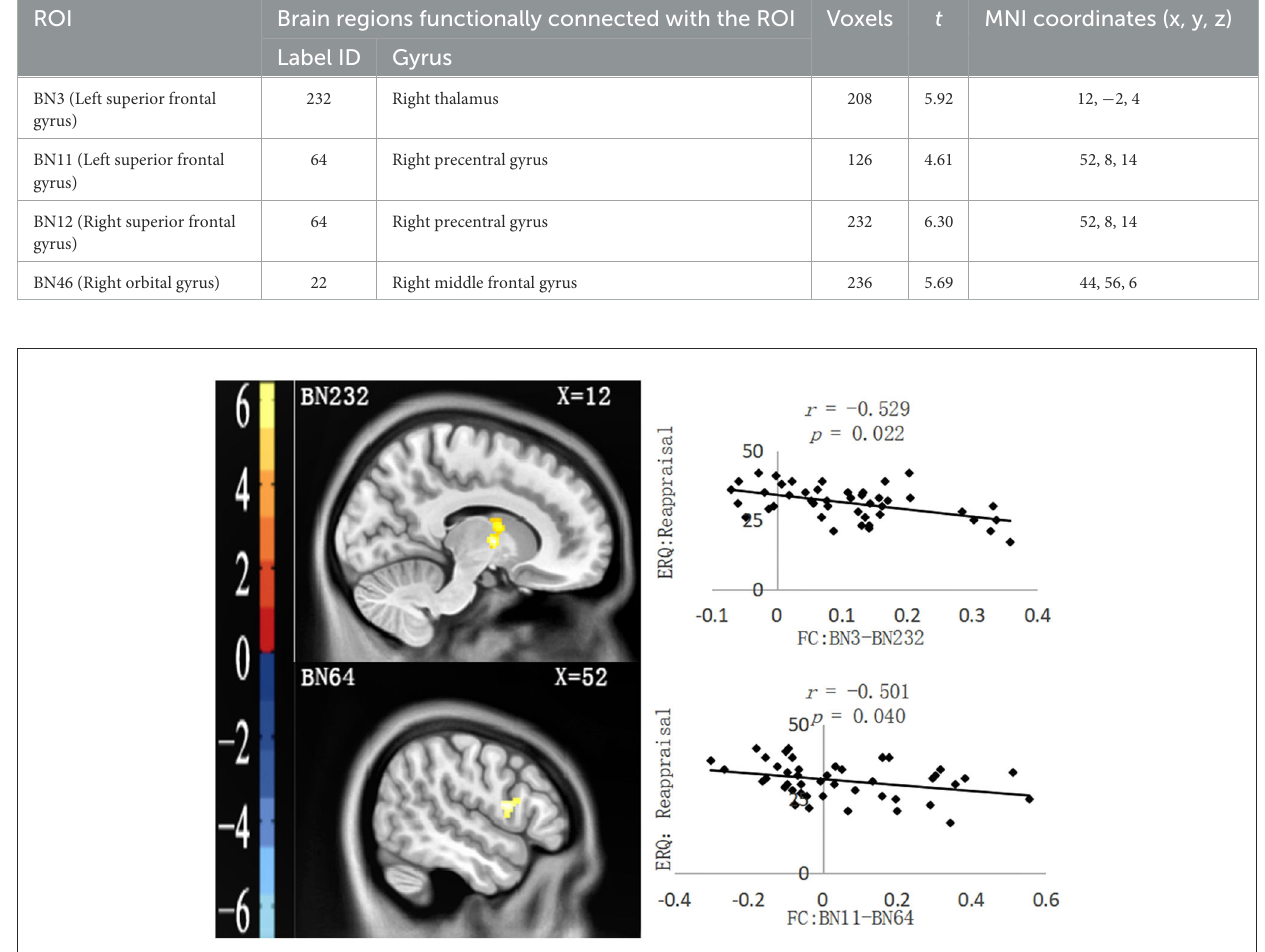
FIGURE1 Functional connections (neglect group > control group) significantly correlated with ERQ: reappraisal. Left : Brain regions functionally connected with the ROIs. Right : Scatter plot of the correlation between the FC value and ERQ reappraisal. All the p- values underwent Bonferroni corrections.